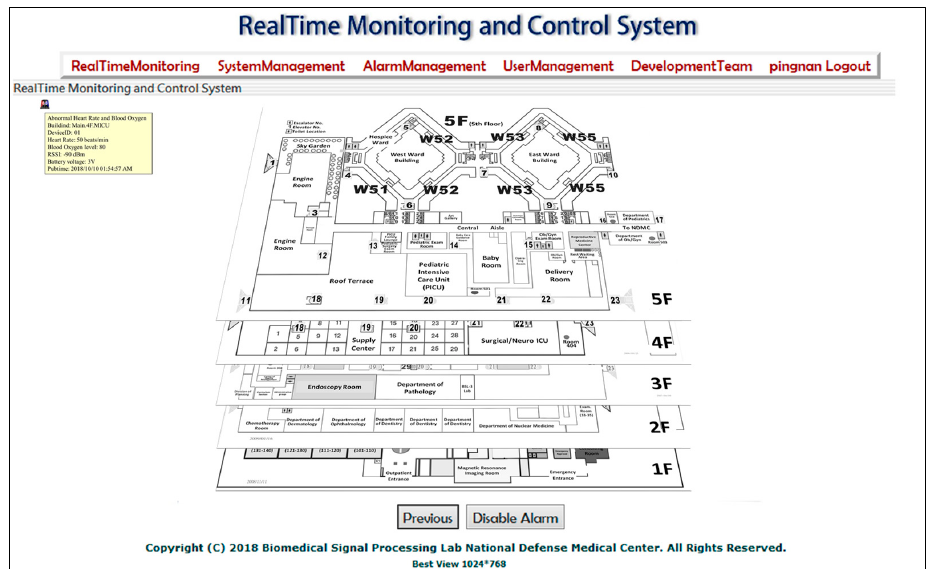
Figure 11. Level 2 includes the layouts of the floors where the ICUs are located.